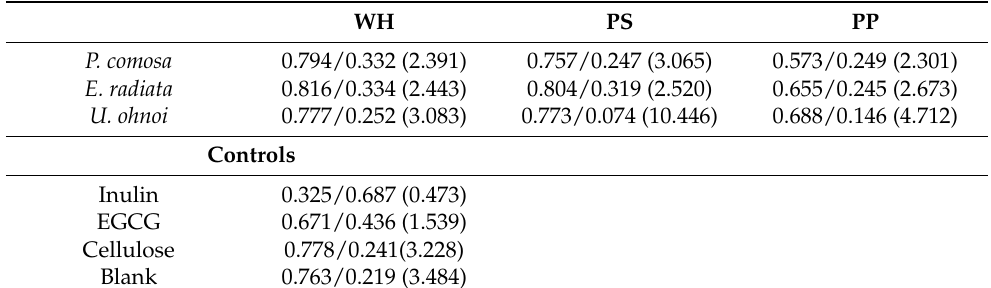
Table 9. Ratio of Firmicutes/Bacteroidetes in seaweed ferments, INU, EGCG or cellulose standards, and the blank at 24